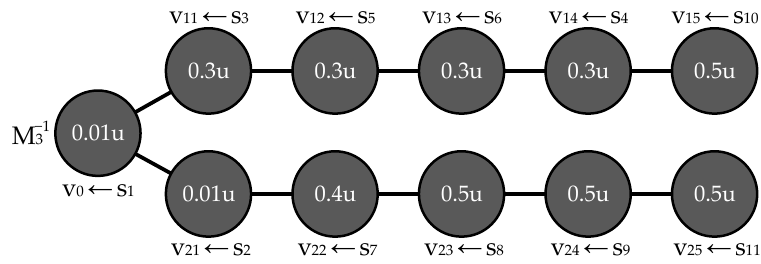
Figure 4. Example of a placement that is a solution to problem (2).